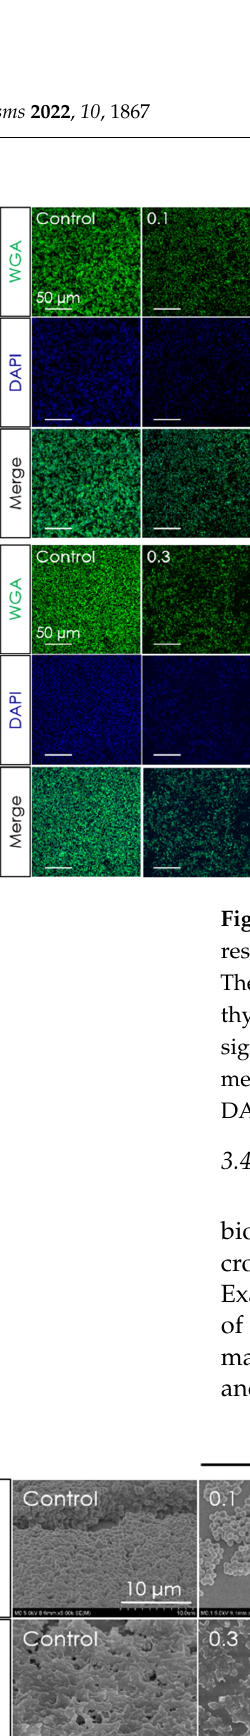
concentrations of thymol. The minimum biofilm eradication concentrations (MBECs) of thymol by